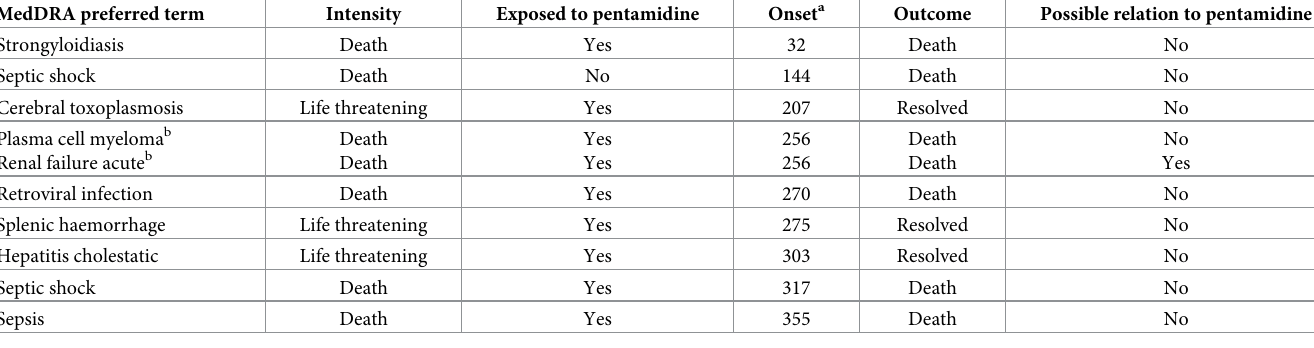
Table 3. Serious adverse events occurring during follow-up after negative parasitology. MedDRA preferred